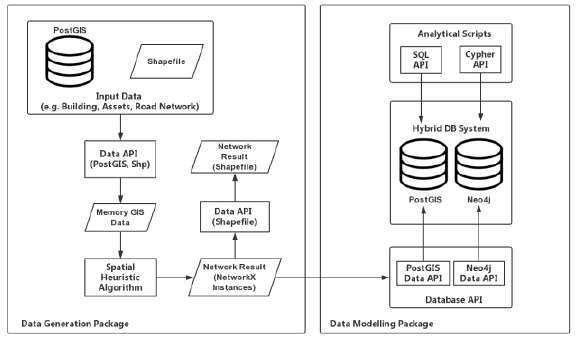
Figure 1. Overall architecture of the infrastructure network analysis framework.